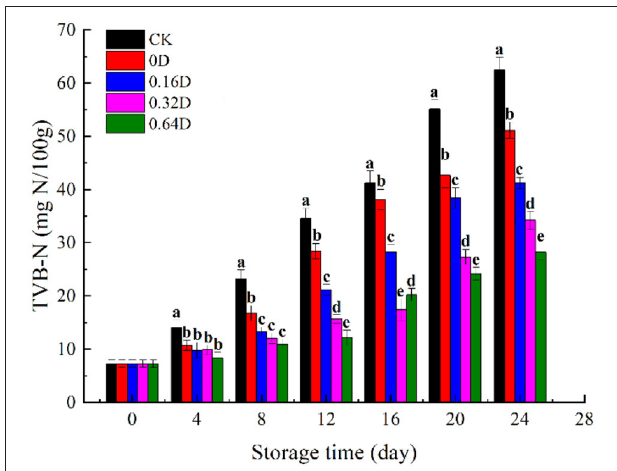
FIGURE 2 | Changes in total volatile basic nitrogen values (TVB-N) of turbot samples during refrigerated storage [CK, washed with deionized water; 0D, immersed in weakly acidic electrolytic water (WAEW) for 10min, followed by a coating with a locust bean gum–sodium alginate (LBG-SA)-active coating; 0.16D, immersed in WAEW for 10min, followed by a coating with an LBG-SA coating with 0.16 g/L daphnetin; 0.32D, immersed in WAEW for 10min, followed by a coating with an LBG-SA coating with 0.32 g/L daphnetin; 0.64D, immersed in WAEW for 10min, followed by a coating with an LBG-SA coating with 0.64 g/L daphnetin].